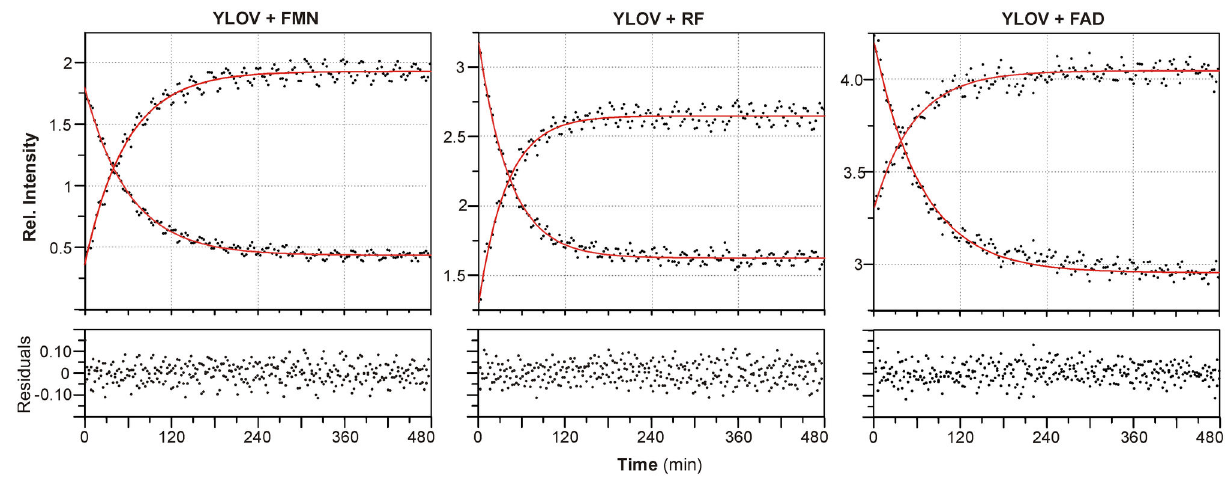
Figure 4. Ground state recovery of YLOV reconstituted with FMN, RF or FAD. Ground state recovery of YLOV either reconstituted with FMN, RF or FAD was monitored by tracking the intensity changes of a rising and a falling resonance signal within 1 H-NMR spectra continuously recorded during the conversion process. Two representative 1 H-NMR spectra including the monitored resonance signals are given in Figure S6 in the supplementary material. The intensities were plotted against time and fitted using a mono-exponential decay function (red line) with the calculated half-lives given in Table 3. The corresponding residuals (rmsd) are displayed at the